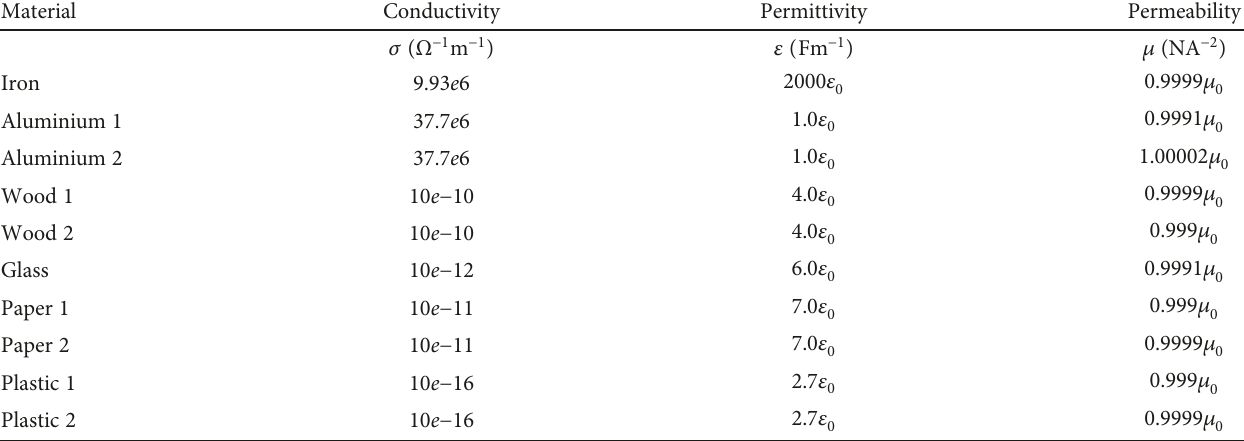
Figure 16: Media distribution within the o ffi ce indoor herein studied. The values of the physical parameters characterising each material are shown in Table 5. Table 5: Physical parameters of the materials considered for the indoor propagation depicted in Figure